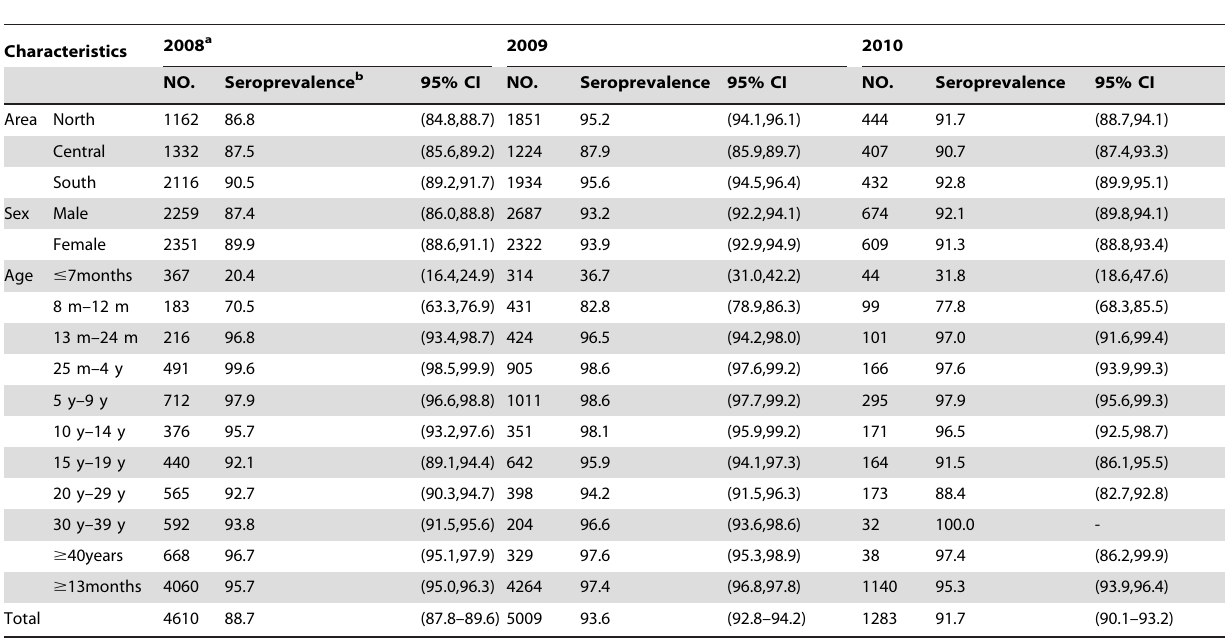
Table 2. Seroprevalence of measles antibodies by region, sex, and age group in the Jiangsu province, 2008–2010 (%).